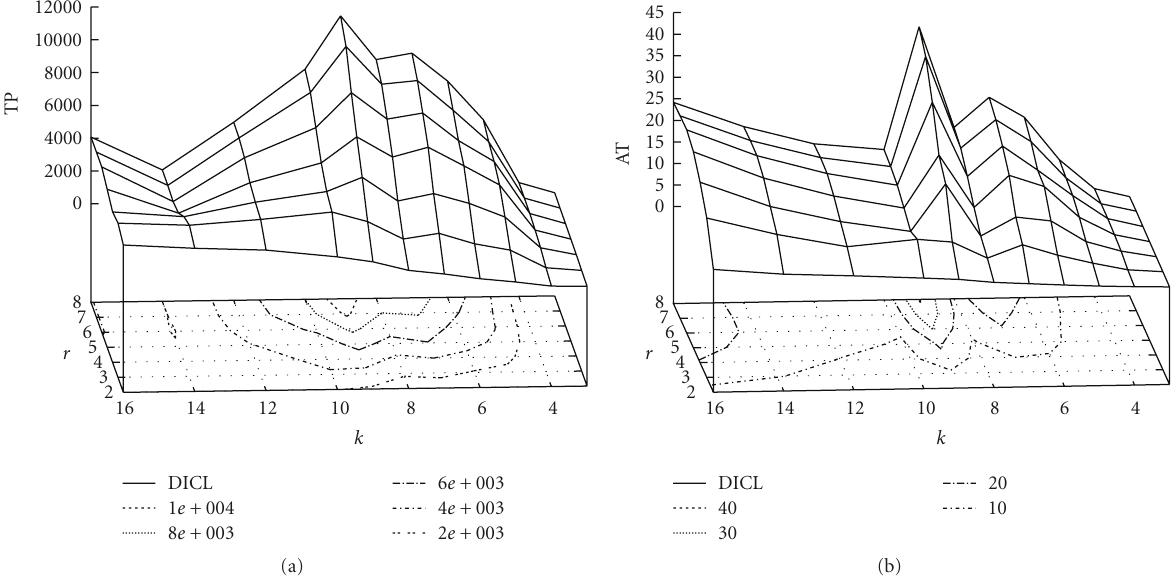
Figure 6: (a) Total possibilities stored in each cluster at any time during unique localization. (b) Simulation running time in seconds during